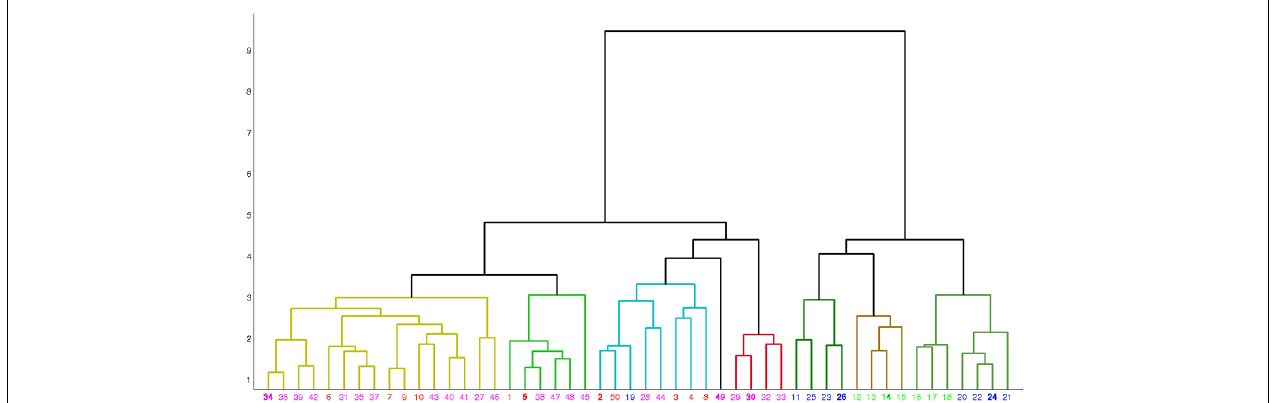
respectively represent neuron types BC, MC, non-MC and ChC. Neurons are grouped into eight clusters and in each cluster the exemplar is emphasized in